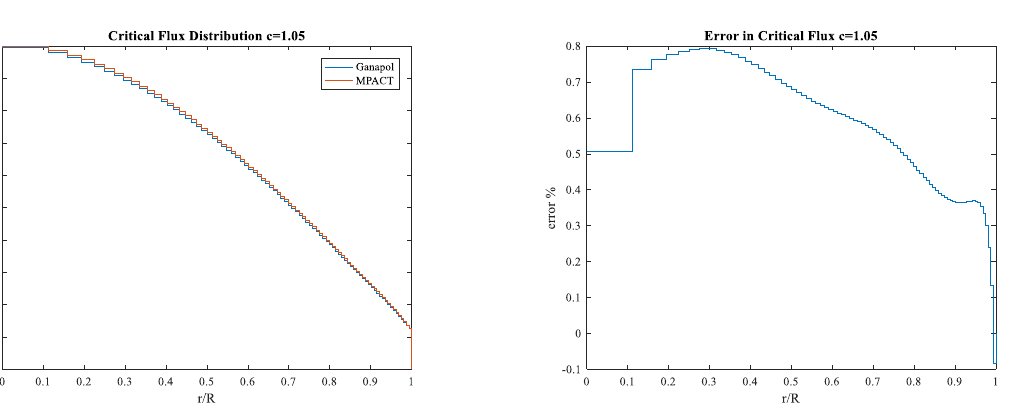
Figure 9. Cell-averaged critical flux comparison Figure 10. Error in the cell-averaged critical